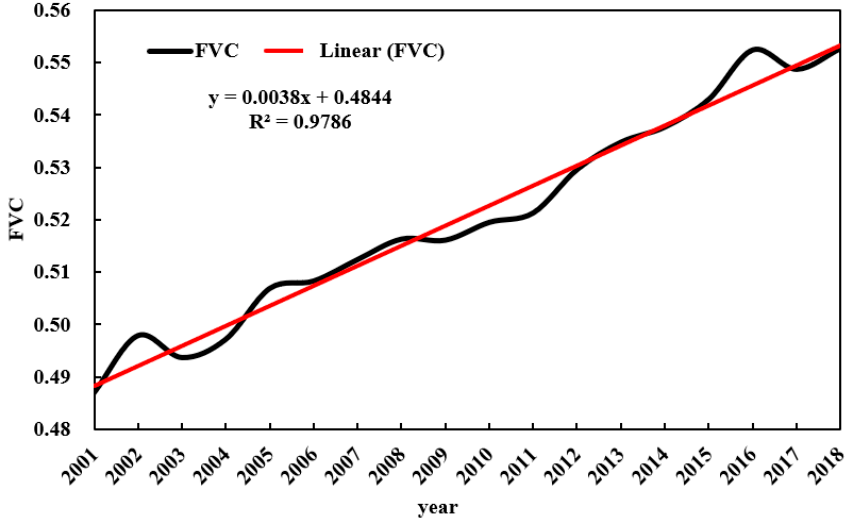
Figure 4. The variation trend of subtropical FVC from 2001 to 2018.